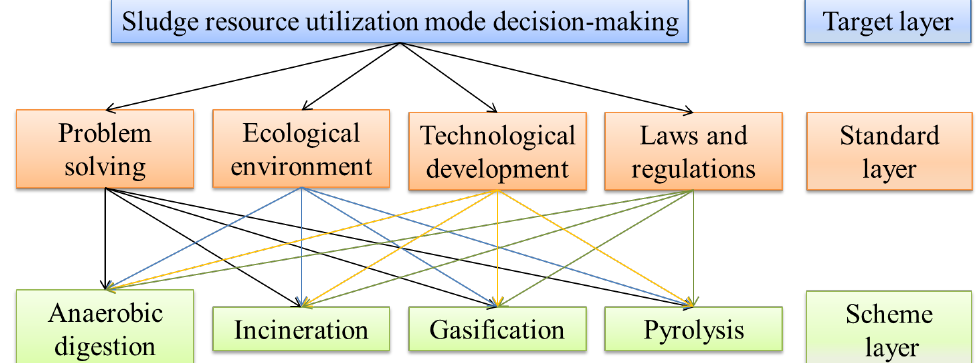
Figure 4. The decision hierarchy model of municipal sewage sludge.